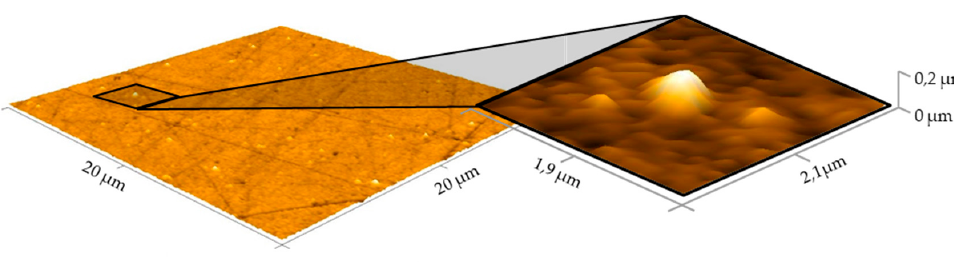
Figure 14. Magnification of an adhesion defect in real aspect ratio.